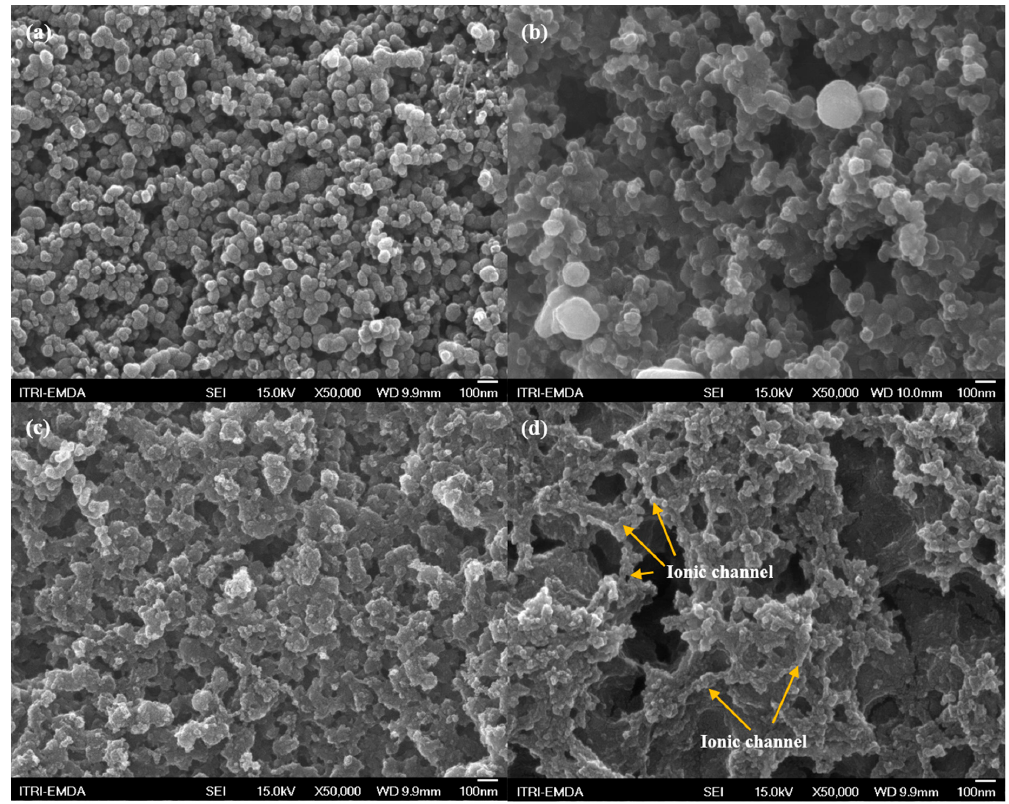
Figure 4. The SEM images of the SP and the MA electrodes ( a , b ) before charge and ( c , d ) after 50 cycles.